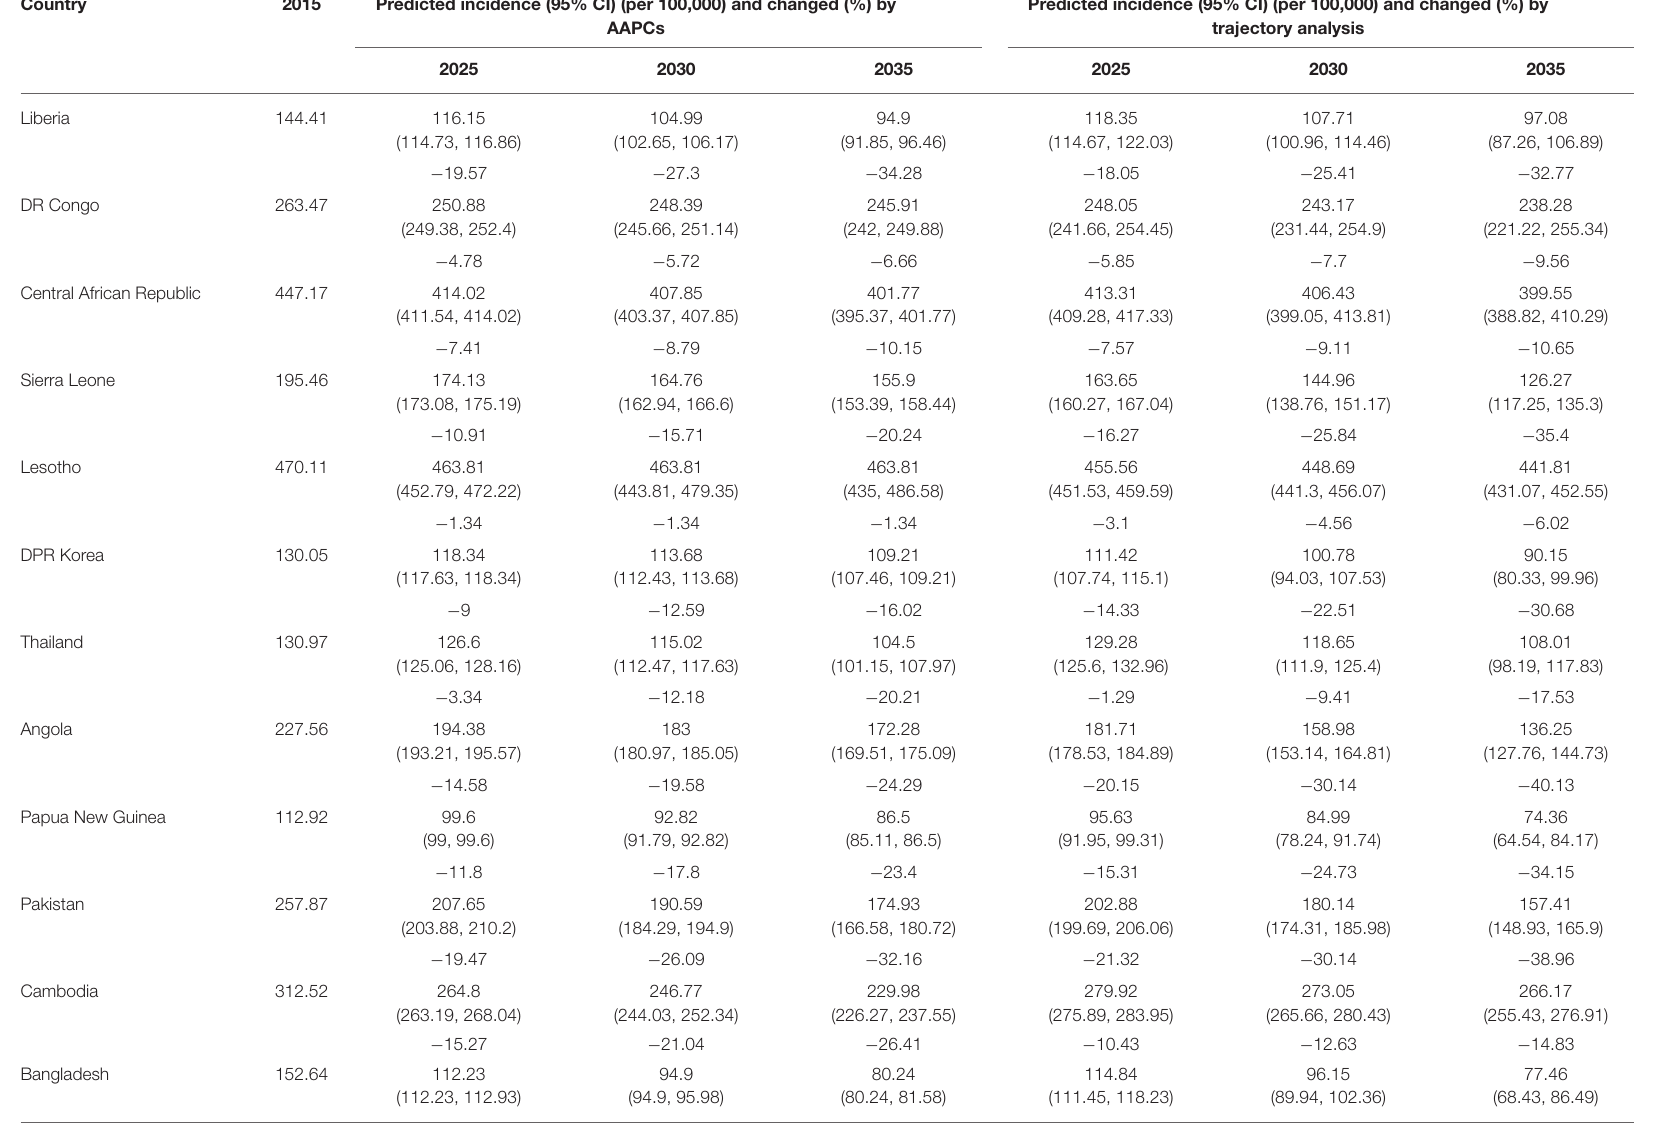
TABLE 2 | Predicted incidence and mortality of TB in 2025, 2030, and 2035 in 30 HBCs.